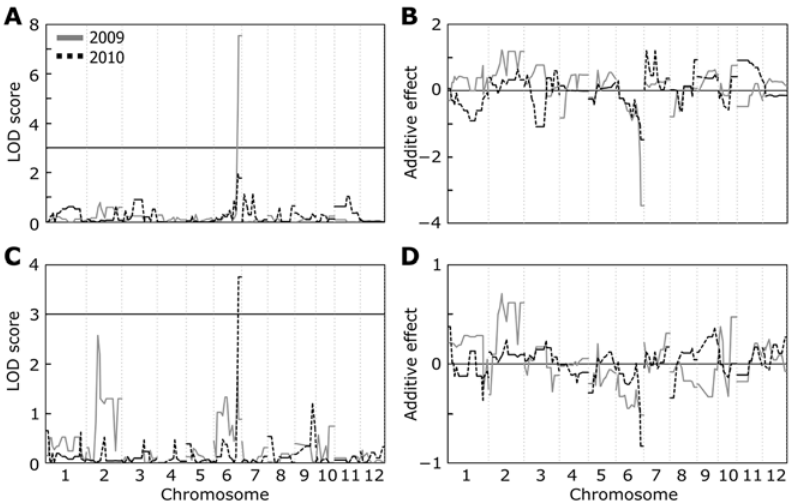
Fig 2. Genome scans for ozone-induced yield loss and the number of primary rachis branches. (A, C) QTL likelihood maps for (A) grain yield and (C) the number of primary rachis branches. Genetic maps were produced by composite interval mapping using differences between ambient air and elevated ozone. (B, D) Additive effect of (B) QTLs for grain yield and (D) the number of primary rachis branches. A positive (negative) additive effect in B and D represents an increasing allele from Sasanishiki (Habataki). The vertical dotted lines separate chromosomes 1 – 12 (labeled at the bottom) progressing left to right along the x -axis.